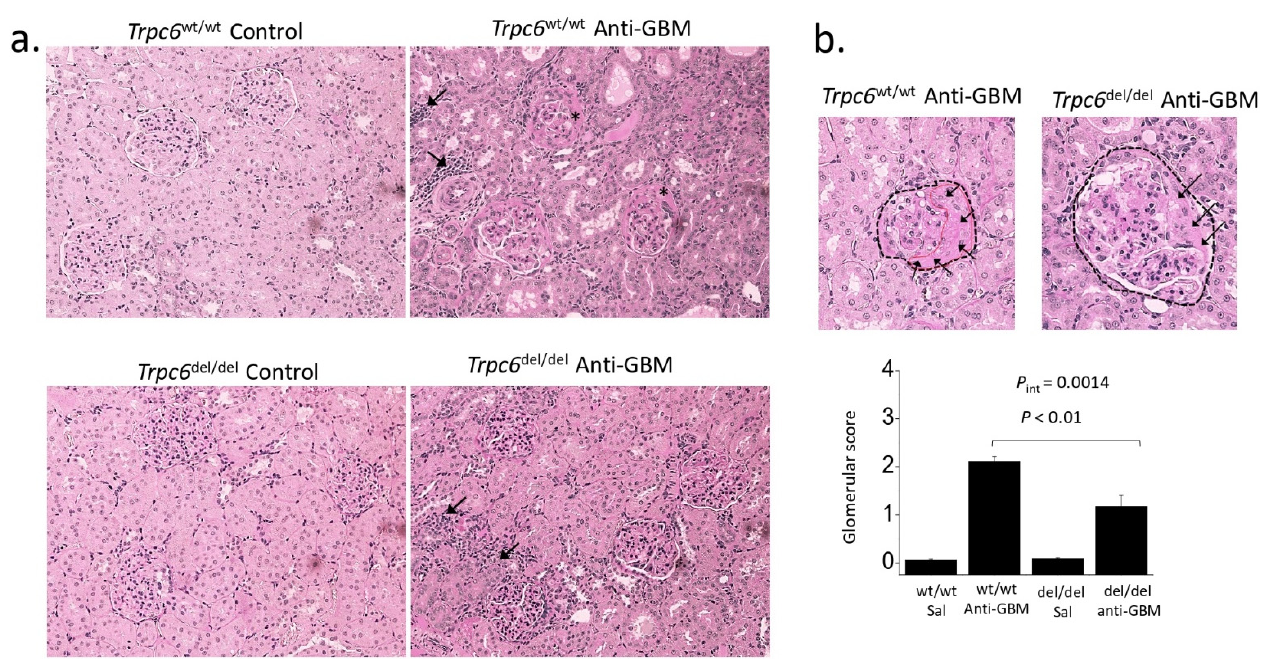
Figure 4. Glomerular damage and interstitial disease in anti-GBM glomerulonephritis in rats. ( a ) Note severe glomerulosclerosis in a Trpc6 wt/wt rat during autologous phase of anti-GBM nephritis. There is also marked hypercellularity in tubulointerstitial areas (arrows) and many of the tubules are dilated, and hyalinization is present. Glomerulosclerosis is present but is less severe in a Trpc6 del/del rat but tubulointerstitial disease is still present. ( b ) Semi-quantitative analysis shows that glomerulosclerosis is less severe during anti-GBM nephritis in Trpc6 del/del rats compared to Trpc6 wt/wt littermates. Additional details and analyses are in [51].